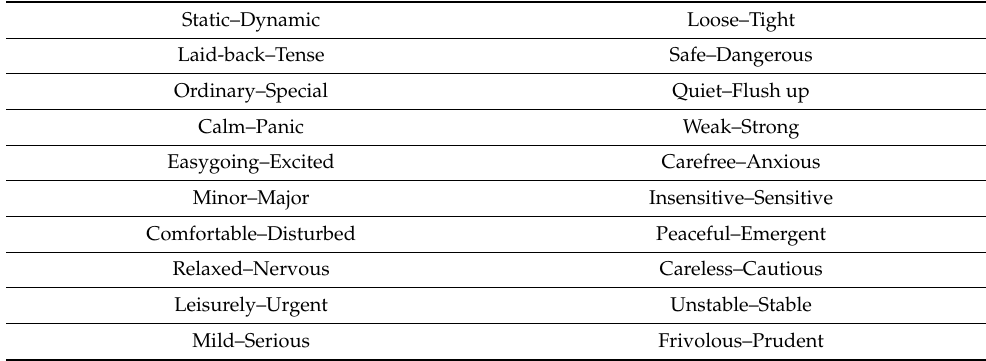
Table 5. Kansei words used in the second